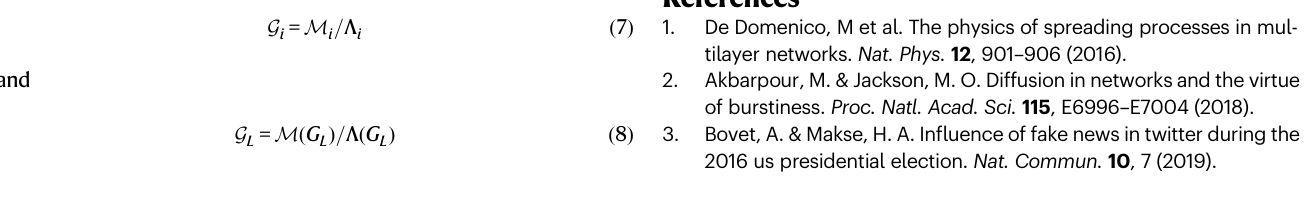
Fig. 9 | Multiplex network formed by layers G 1 and G 2 connected by weighted links with equal interlayer strength. Nodes in blue/red represent those that decrease/increasetheirdiffusioncapacityinthefullycoupledmultilayerstructure, compared to their diffusion capacity in isolation ( A ).Diffusion Capacity Λ of G 1 , G 2